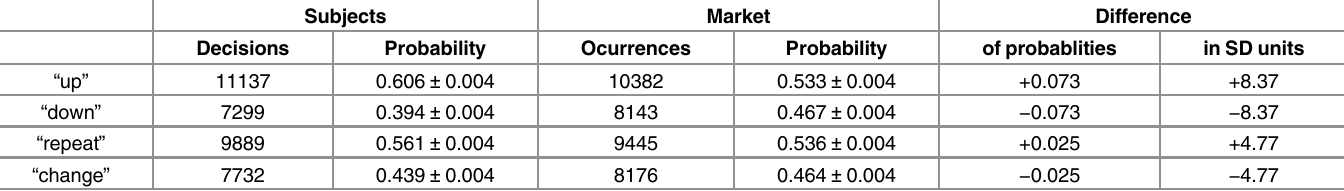
Table 1. Behavioural biases with respect to the market